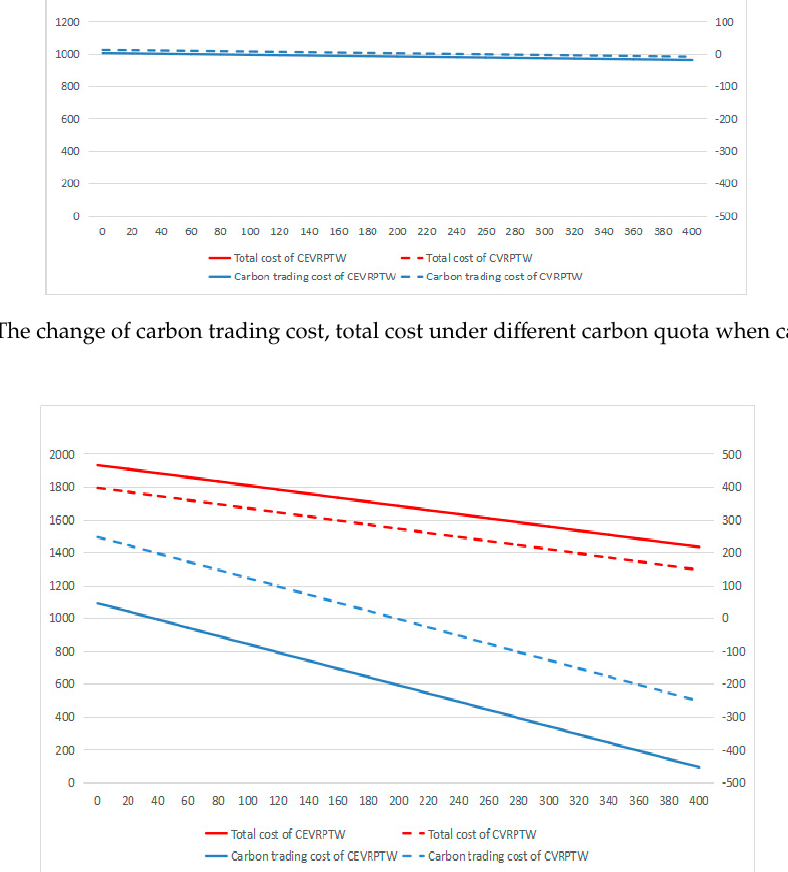
Table 11. The proportion of the cost when carbon price is 1.25. CEVRPTW